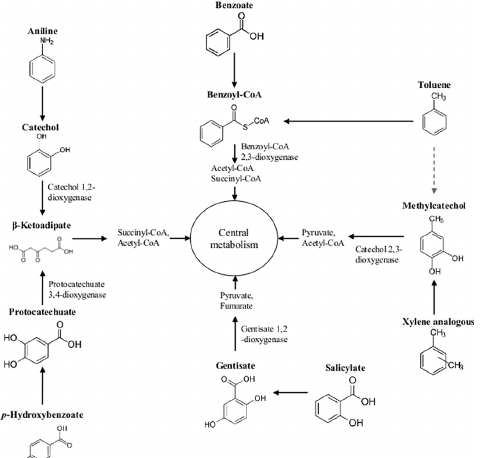
Fig 3. Overview of monocyclic hydrocarbon biodegradation pathways in Burkholderia sp.